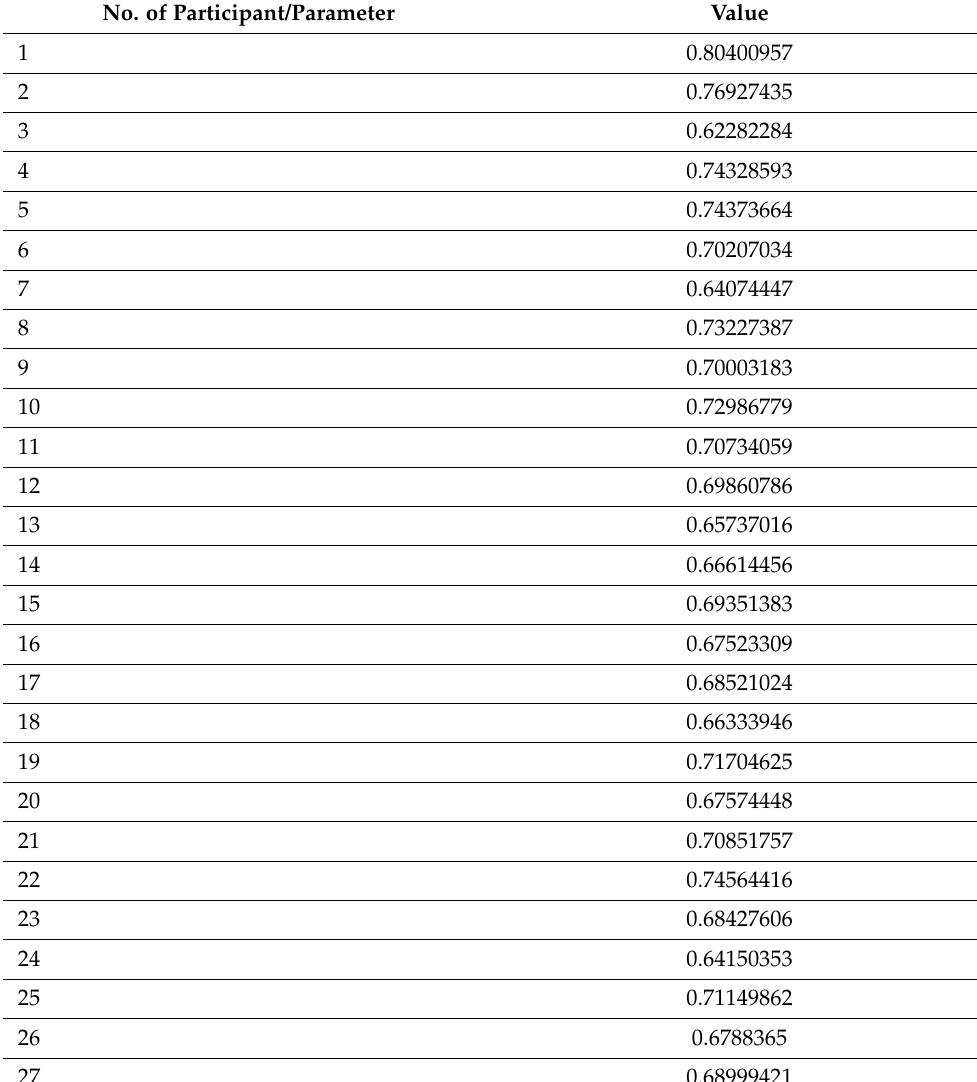
Table 5. Fuzzy model outcomes for studied Group